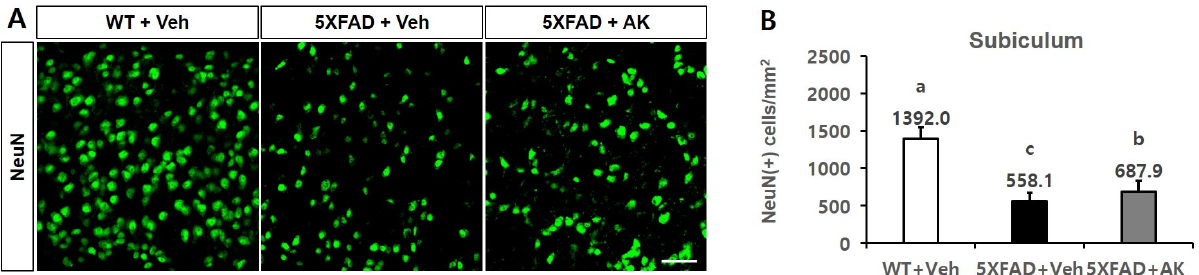
Figure 12. Inhibitory effects of AK extract on neuronal cell apoptosis of the subiculum observed by immunohistochemistry using NeuN antibodies. ( A ) Photographs of amyloid plaques in the subiculum dyed with NeuN antibodies. ( B ) Number of NeuN antibody-positive cells in the subiculum. Scale bar = 50 µ m. WT + Veh: wild type normal group; 5XFAD + saline: control group; 5XFAD + AK extract: AK extract group ( n = 5). AK extract 200 mg/kg/day was orally administered for 21 days. Statistical analysis was performed using SAS software. The values indicated with different letters were observed to differ significantly at p < 0.05 by Duncan’s multiple range test.